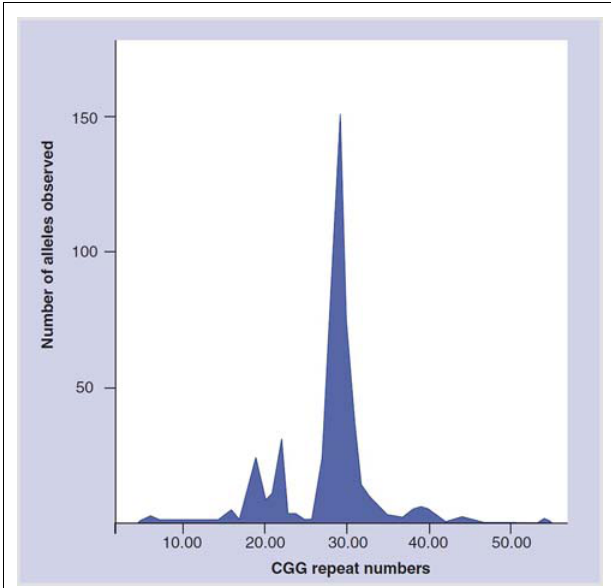
FIGURE 1 | Distribution of CGGn in general population. Modified with permission from Fu etal. (1991).